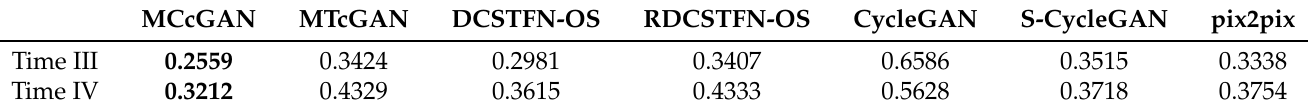
Figure 8. The SSIM results of different methods for different bands in Area B at Times III and IV. Table 7. The spectral angle mapper (SAM) of different methods in Area B at Times III and IV (the bold result is the